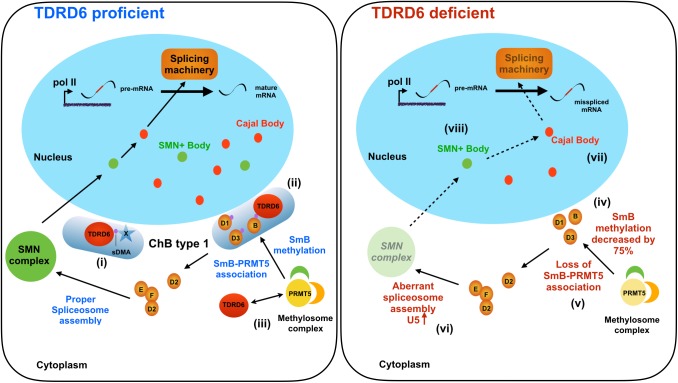
Proposed functions of TDRD6 in primary spermatocyte spliceosome assembly.Shown are primary spermatocytes that are TDRD6 proficient (left) or deficient (right). TDRD6 resides in the chromatoid body (ChB) type 1 of TDRD6 proficient primary spermatocytes and associates with sDMA-modified proteins (represented by blue star-shaped protein X; the violet dot indicates sDMA) (i) such as sDMA-containing SmB, a member of the Sm protein group (B, D1, D2, D3, E, F) (ii). TDRD6 and PRMT5 interact (iii). In TDRD6 deficient primary spermatocytes, no ChB type I form, PRMT5 association with SmB is impaired, (iv) and symmetrical dimethylation of SmB is decreased by 75% (v). U5 spliceosome assembly is upregulated compared to TDRD6 proficient cells and an aberrant SMN complex forms (vi). In the nucleus, the numbers of Cajal bodies (vii) and SMN-positive (SMN+) bodies (viii) are decreased upon TDRD6 deficiency. The names of all proteins and cellular structures are indicated; sDMA, symmetrically dimethylated arginine.